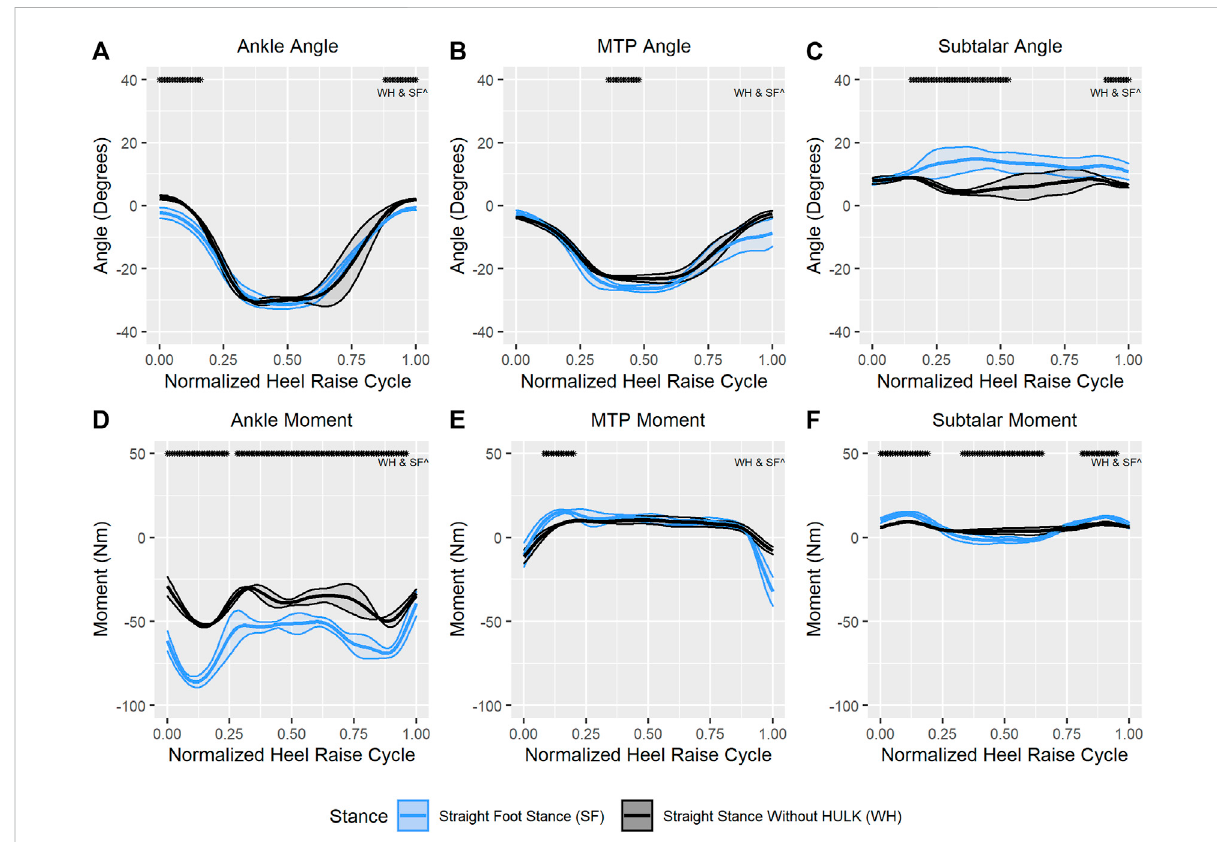
FIGURE 6 Average(±SD)anklejointangle (A) andmoment (D) ,MTPjointangle (B) andmoment (E) ,andsubtalarjointangle (C) andmoment (F) forstraight foot stance and straight stance without HULK conditions through a normalized heel raise cycle. Solid center lines indicate means, and the surrounding shaded areas indicate ±1 standard deviation. Asterisks indicate statistical signi fi cance ( α = 0.05) through a phase of a minimum of 10 consecutive statistically signi fi cant time normalized